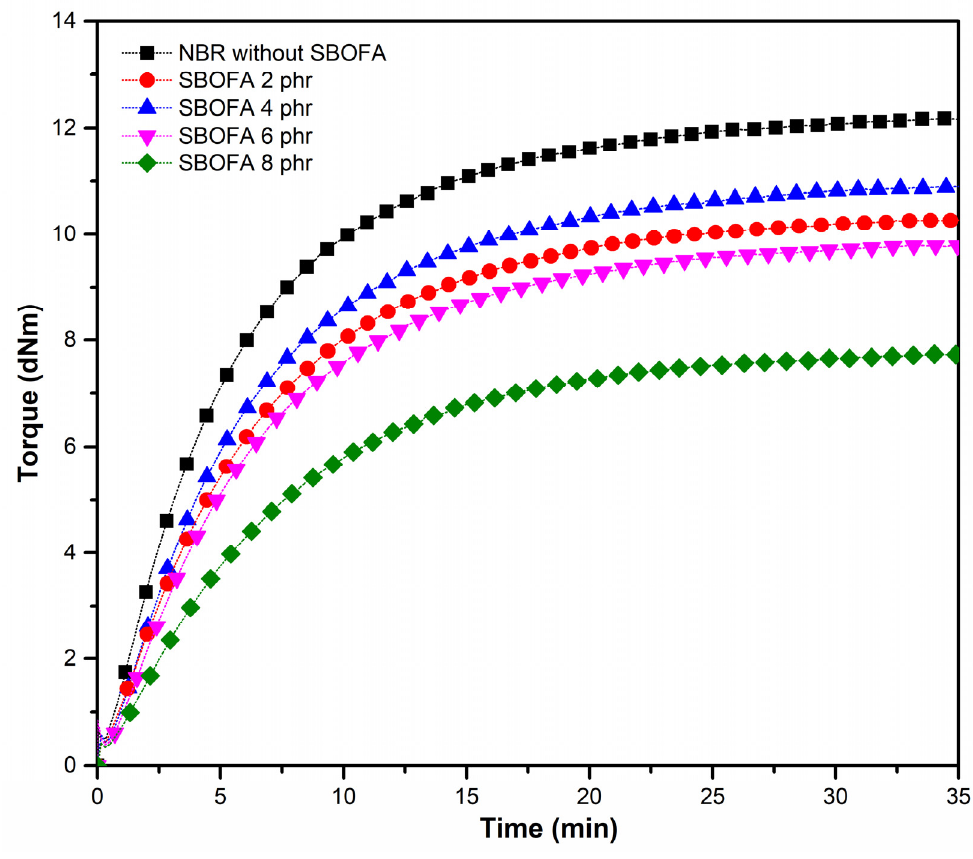
Figure 7. Cure curves of NBR compounds with varying SBOFA loadings.